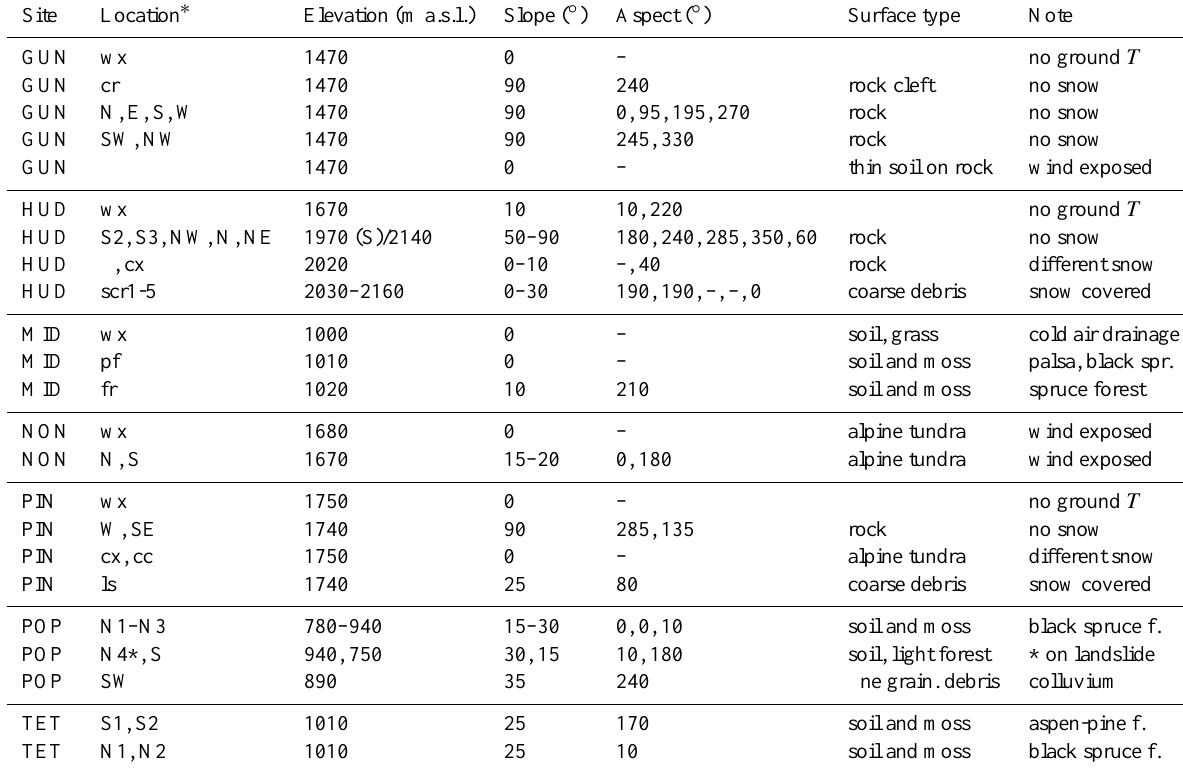
Table 1. Measurement locations at all field sites. Locations with common parameters are summarised.